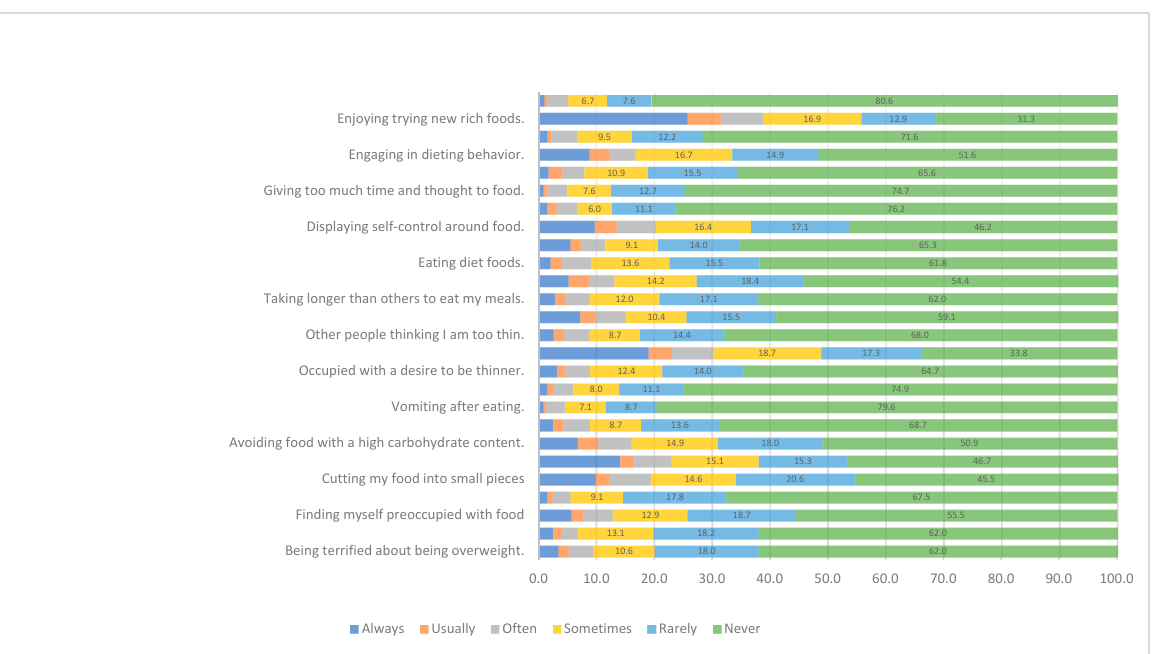
Figure 1. Distribution of responses from the Eating Attitudes Test-26.